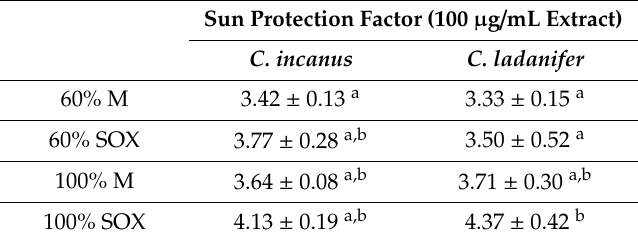
Table 6. Determination of the sun protection factor (SPF) of C. incanus and C. ladanifer extracts.